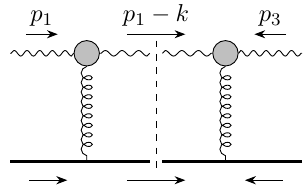
+ p µ = q µ , and s = ( p 1 + p 2 ) 2 1 3